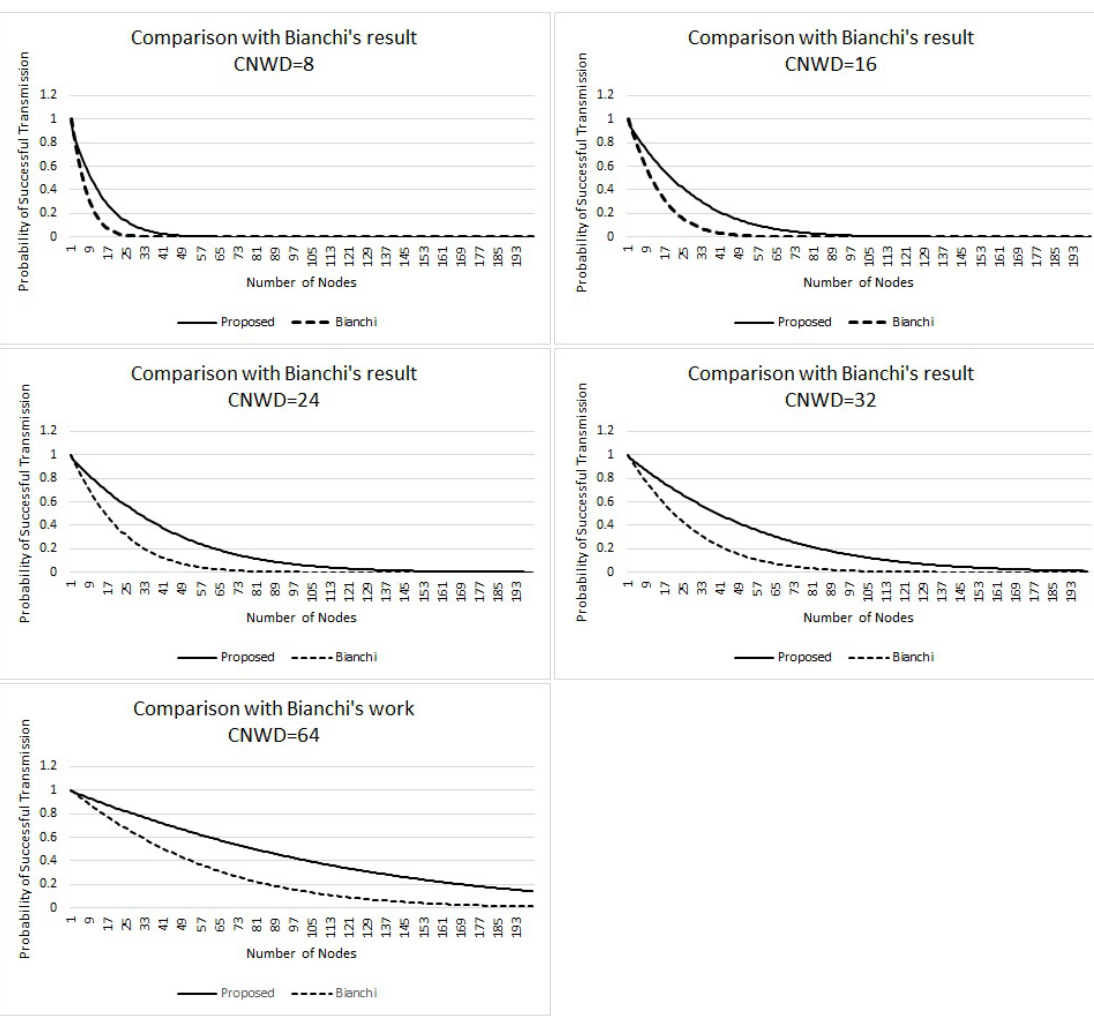
Figure 7. Comparison of Analytical vs. Markov model for CNWD = 8, 16, 24, 32 and